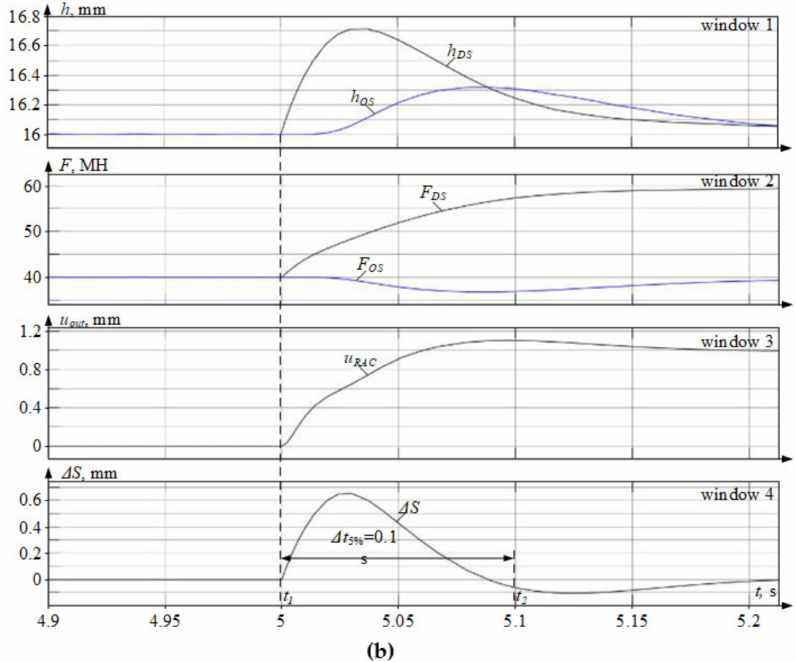
Figure 10. Simulation of misalignment compensation transients associated with a proportional controller ( a ) and a PD controller ( b ): Panel 1 shows gauge curves; Panel 2 shows DS-OS force values; Panel 3 shows the RAC output; window 4 Panel the difference in gauge between different sides ( ∆ S ).